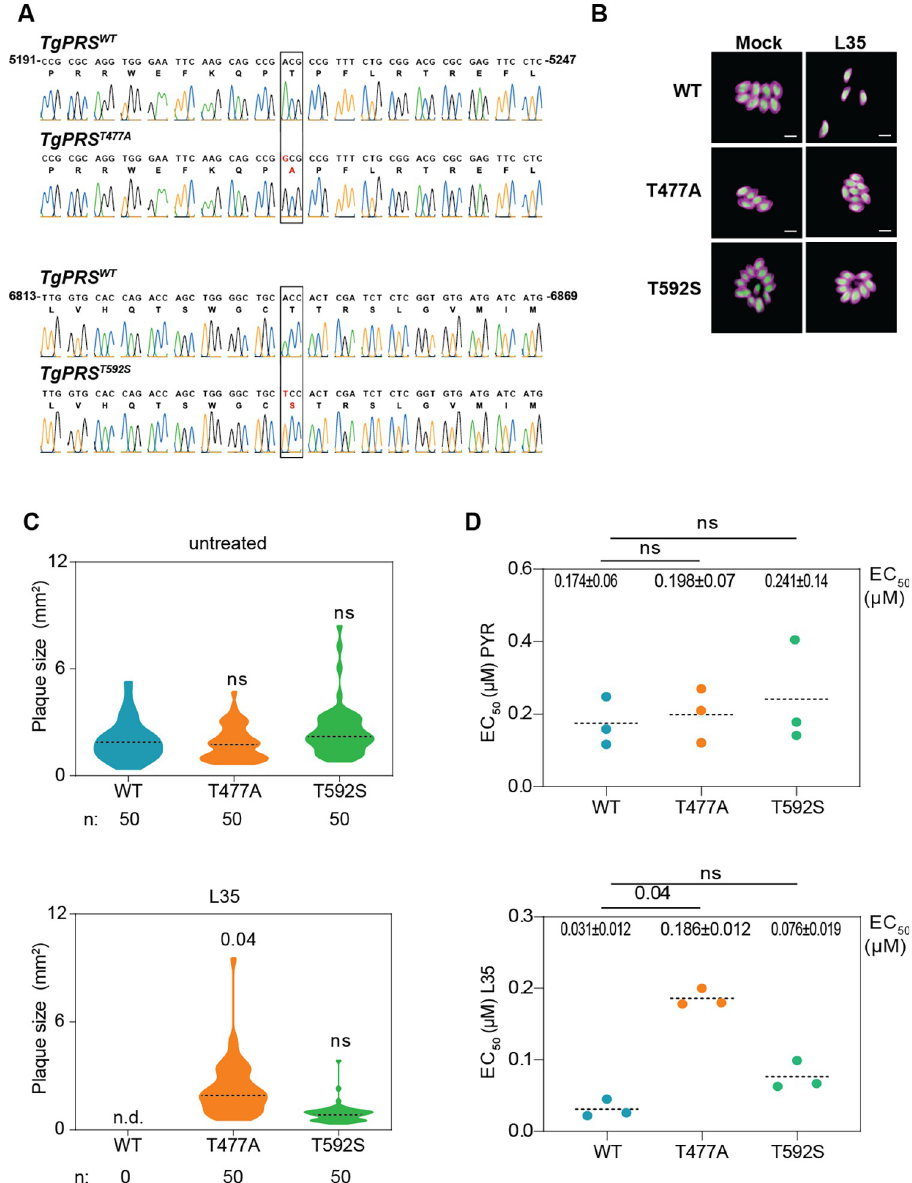
Fig 3. Validation of PRS molecular target. A) Sanger sequencing chromatogram showing PRS editing. Nucleotide positions relative to the ATG start codon on genomic DNA are indicated. A schematic of the strategy used for the CRISPR-mediated gene editing is represented in S2 Fig. B) Fluorescence microscopy showing intracellular growth of WT and the PRS -edited parasites (T477A and T592S). Confluent HFFs were infected with parental or recombinant RH tachyzoites (RH Δ ku80 UPRT :: NLuc- P2A-EmGFP ) and incubated with 0.1 μ M of L35 or 0.1% DMSO as control. The cells were fixed 24h post-infection and stained with anti-GAP45 antibody (magenta). Cytosolic GFP is shown in green. Scale bars, 5 μ m. C) Effects of L35 and PRS mutations on T . gondii lytic cycle were determined by plaque assay. Plaques sizes were measured after 7 days of growth in the presence of the drug or 0.1% DMSO. The graphs represent the size of 50 plaques when detected, and n.d., when not detected. Associated data are in S2 Fig. D) IC 50 values for Pyrimethamine and L35 were determined for wild-type (WT) and the engineered PRS mutant strains (T477A and T592S). The mean ± SD of two independent experiments is shown. On the top of each graph the significant difference is indicated. Statistical analyses were performed by one-way ANOVA test using GraphPad8 software. n.s., not